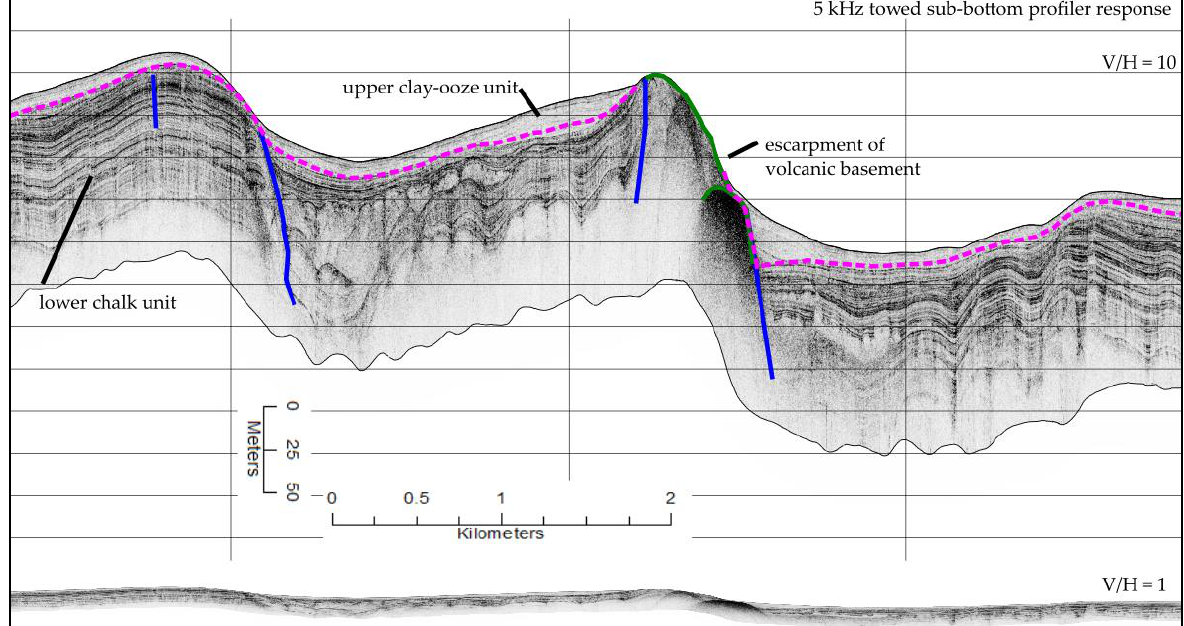
Figure 9. Resource domains in one part of the CCZ nodule deposit. The colour scale represents the seabed bathymetry with example depths for scale. The area is the fore and mid-ground of Figure 8. Photo sites are for Figure 7 and Figures 11–13.